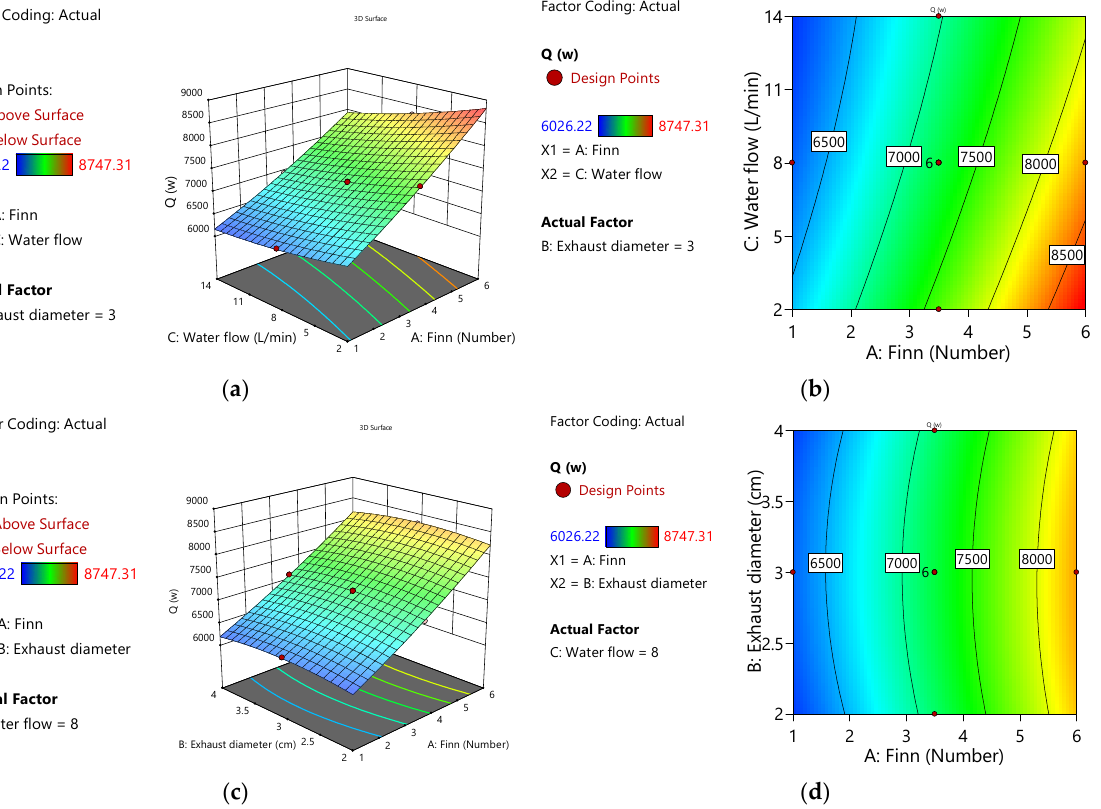
Figure 3. ( a ) Response surface representing e ffi ciency as a function of fi n number and WFR, and ( b ) contour lines representing e ffi ciency as a function of fi n number and WFR.